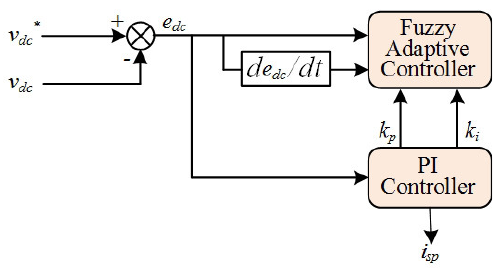
Figure 5. Control loop of the fuzzy adaptive-PI controller for the dc-bus. Table 1. Proposed fuzzy adaptive proportional and integral control matrices ( k p / k i , +: Positive Change,